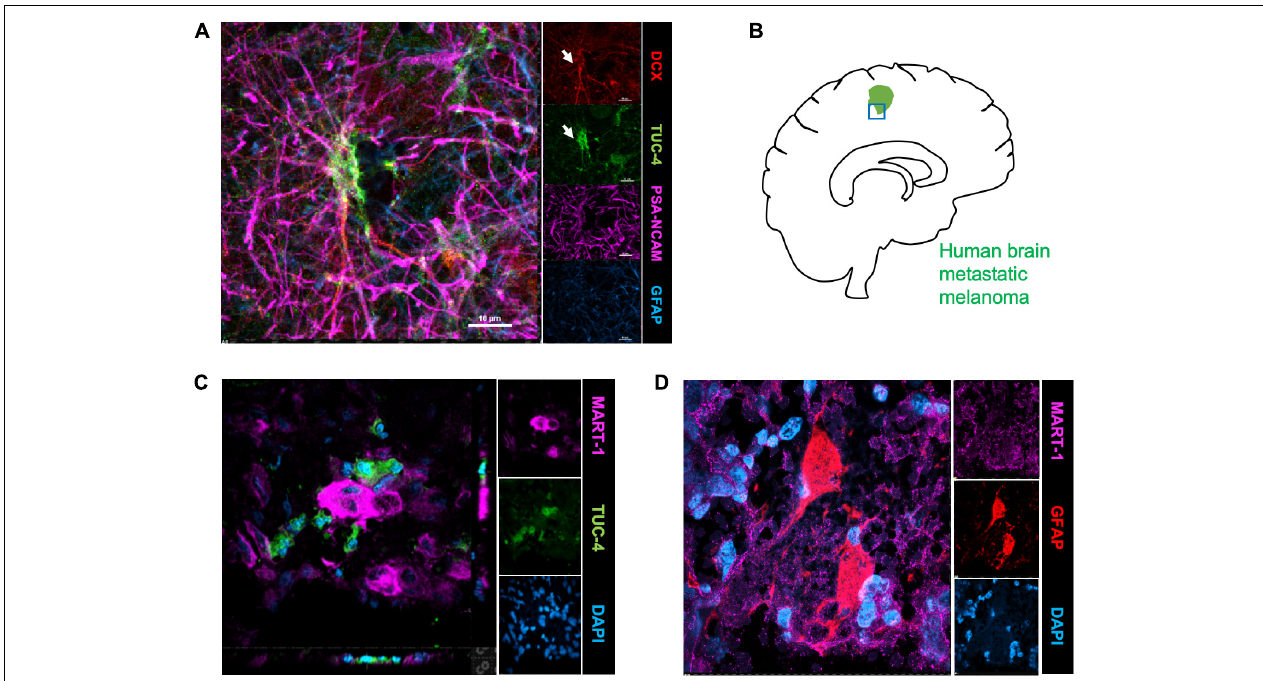
FIGURE 4 | Human brain metastatic melanoma interact with neuroblasts and astrocytes. (A) Representative image depicting characterization of antibodies on human brain samples. Human hippocampus section showing staining for DCX, PSA-NCAM, GFAP, and Tuc-4. DCX positive neuroblasts colocalize with Tuc-4. (B) Schematics showing human brain tumor margin immunostained for neuroblasts and astrocyte association. (C) Immunohistochemical representative images of brain metastatic melanoma show novel interactions with neuroblasts excised from human patients (4/15 show close neuroblast–melanoma interactions). (D) Representative images of brain metastatic melanoma from human patients show interactions with astrocytes.